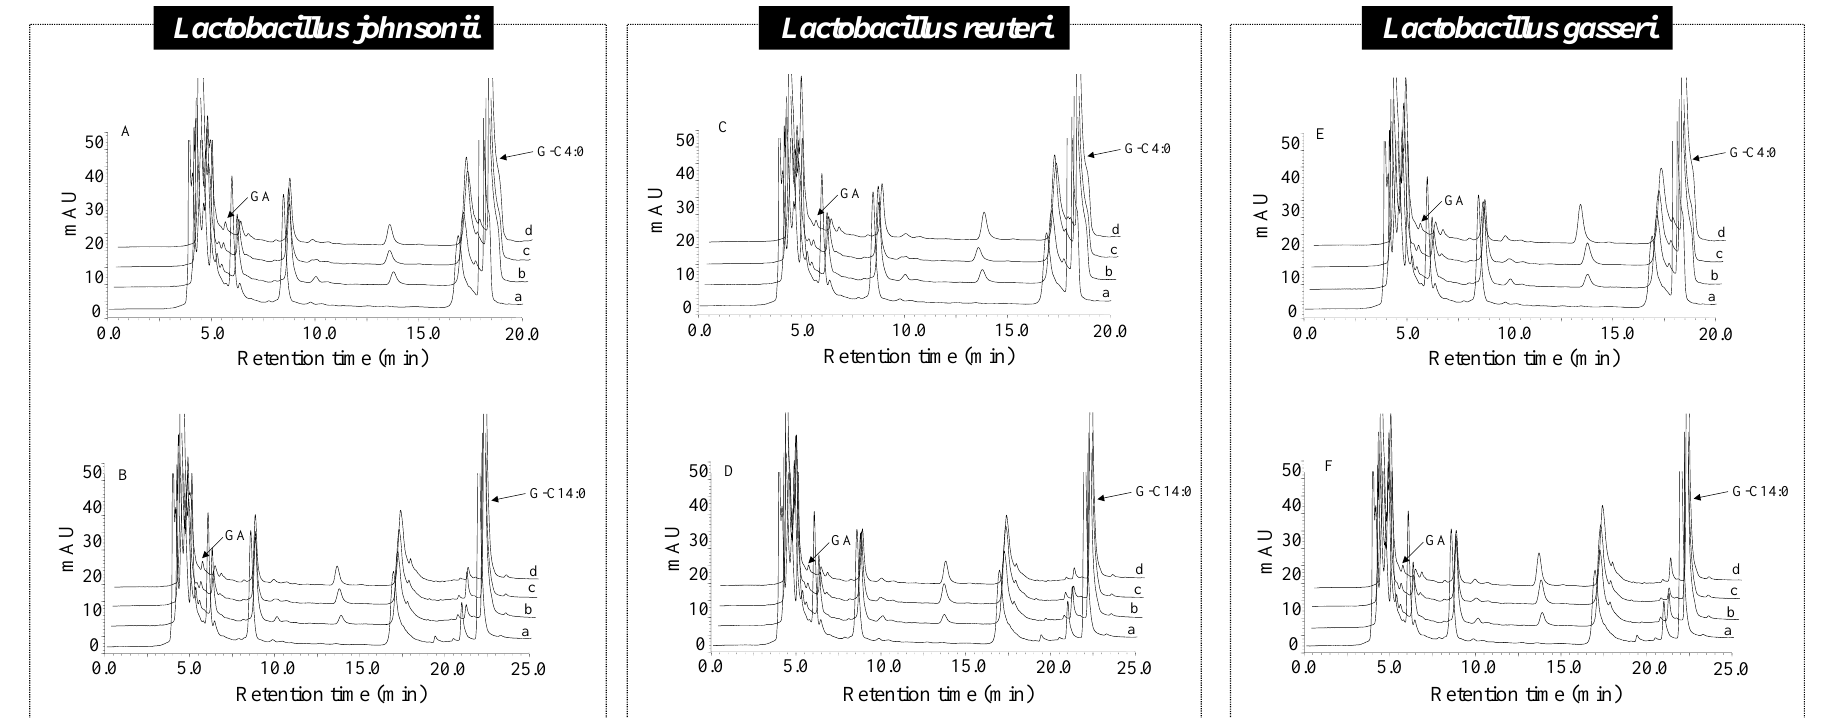
Figure 5. HPLC-UV chromatograms of GA liberated from G-C4:0 ( A , C , E ) and G-C14:0 ( B , D , F ) by Lactobacillus johnsonii , Lactobacillus reuteri and Lactobacillus gasseri : 0, 24, 48 and 72 h (a – d, respectively).